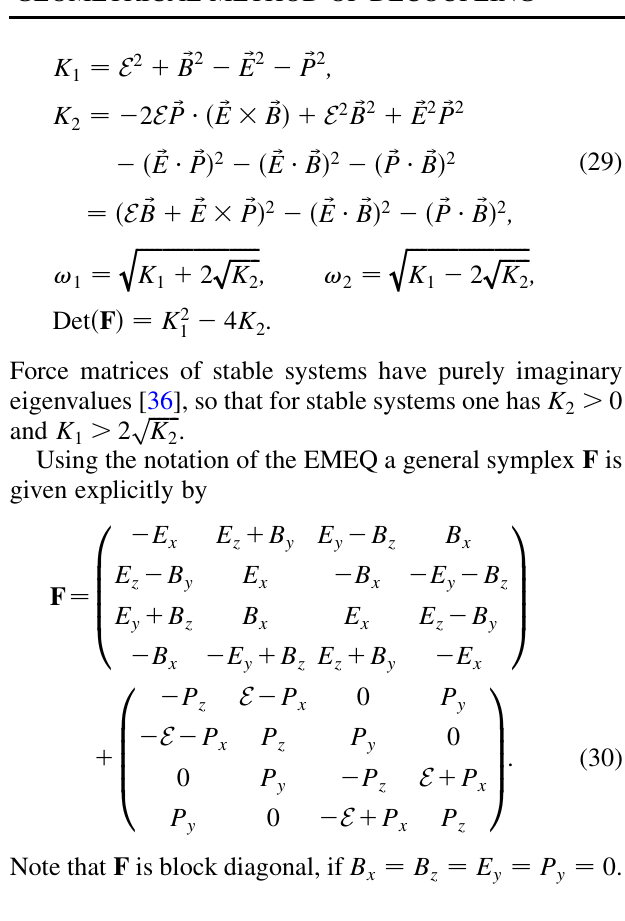
be aligned along the y axis and the vectors ~P and ~E should